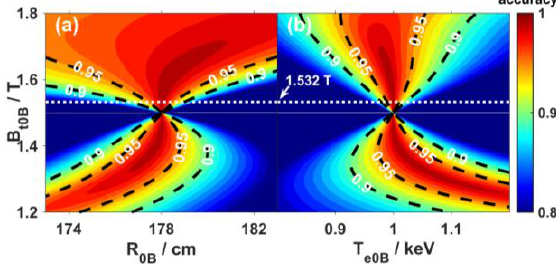
Fig. 5. The dependence of calibration accuracy on (a) R 0B and B t0B , (b) T e0B and B t0B ( R 0B = R 0A ) where T e0A = 1 keV, R 0A = 178 cm, and B t0A = 1.5 T.